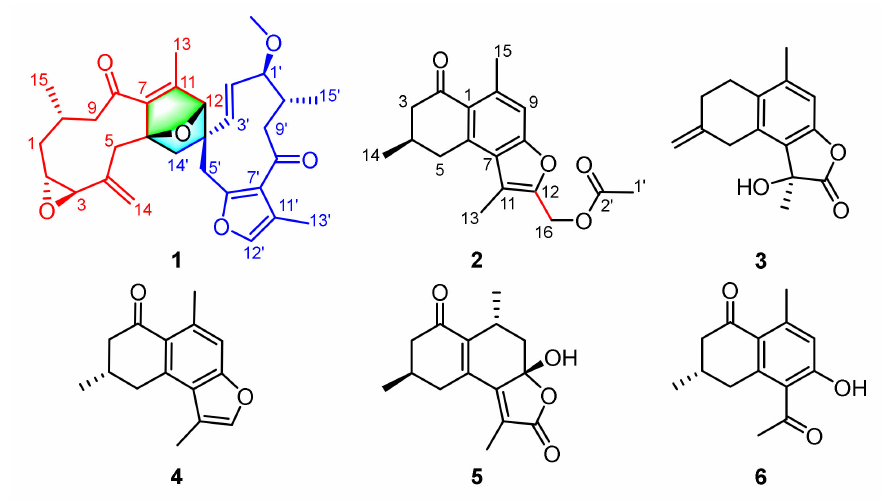
Figure 1. The structures of compounds 1 – 6 from Resina Commiphora